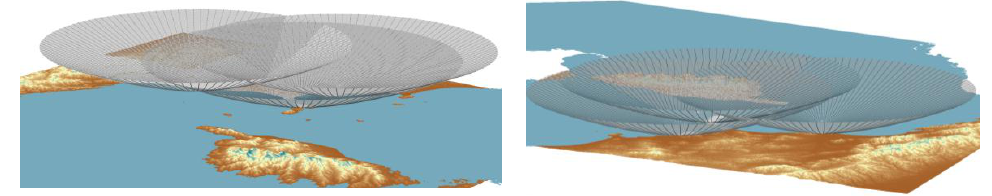
Figure 2. Different overviews of the 3D geolocation of the Plan Position Indicator (PPI) conical scans geometry for the three X-band radars. Elevation is 5°.